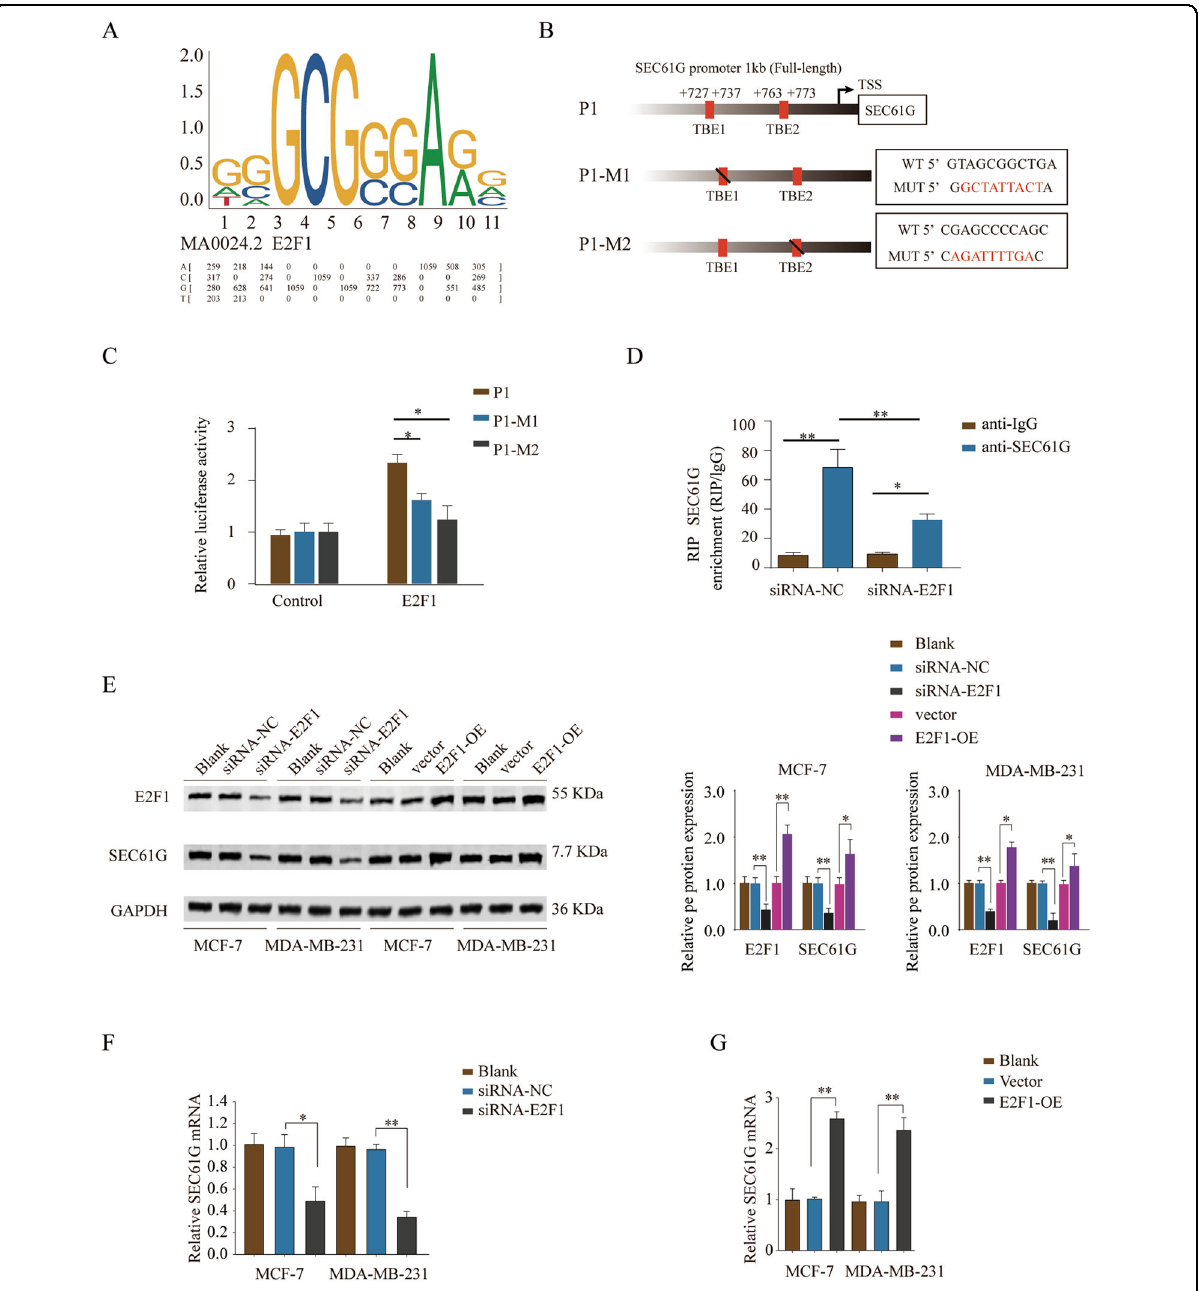
Fig. 6 Transcription factor E2F1 directly binds to the promoter of SEC61G and regulates the expression of SEC61G in breast cancer cells. A The putative binding motif of E2F1 was predicted by using the JASPAR database (http://jaspar.generg.net) and Matrix pro fi le. B The diagram showed the putative WT TEAD binding elements (TBE) located in the promoter region of the SEC61G gene. Luciferase reporter vectors containing WT TBE1/TBE2 (P1), mutated TBE1 (P1-M1), or mutated TBE2 (P1-M2) were constructed. C Luciferase reporter vectors containing WT or mutated TBE sequences were co-transfected with control or E2F1 overexpression vector into HEK293 cells. The relative luciferase activity was analyzed 48 h later. D HEK293 cells were transfected with siRNA-NC or siRNA-E2F1 and then RNA immunoprecipitation Chip (RIP) assay was performed using control IgG or SEC61G antibody. The SEC61G enrichment was analyzed by qPCR. E – G MCF-7 or MDA-MB-231 cells were transfected with siRNA-NC, siRNA-E2F1, empty vector, E2F1 overexpress vector (OE), or left untreated (Blank). E The protein expression of E2F1 and SEC61G was analyzed by western blot. GAPDH was used as a loading control. F , G The relative expression of SEC61G mRNA in MCF-7 or MDA-MB-231 cells was analyzed by qPCR. * P < 0.05, ** P <